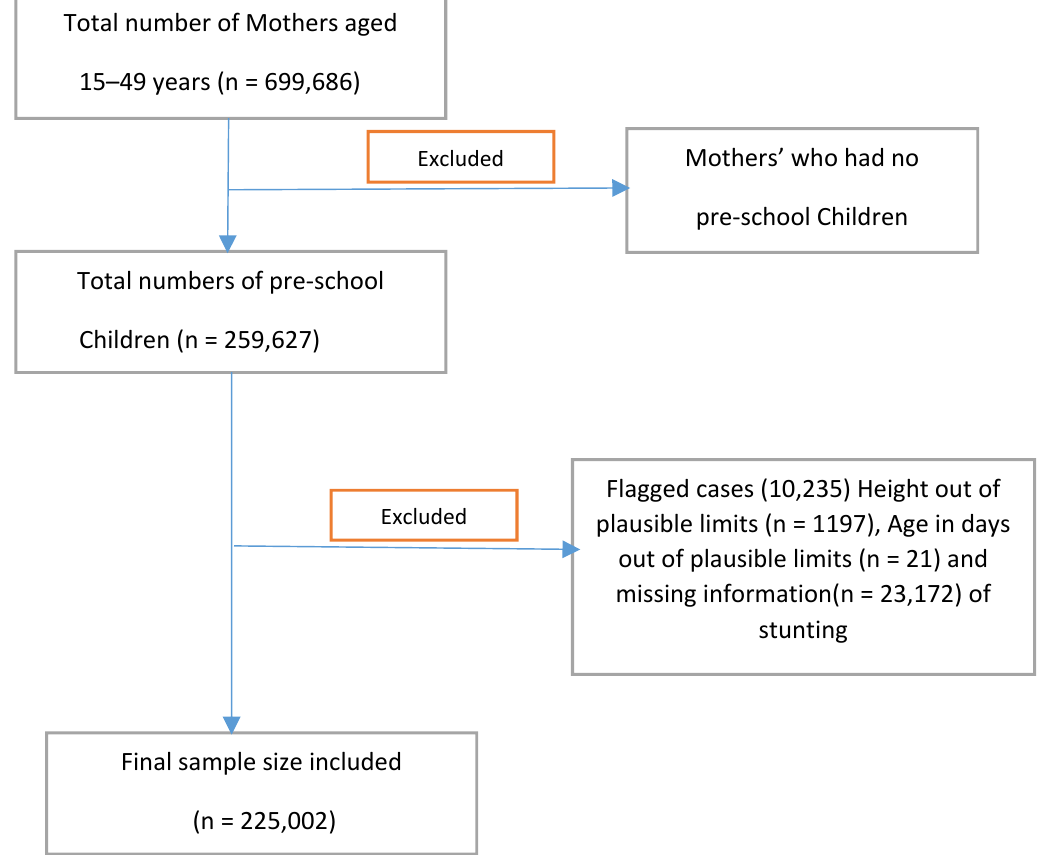
Figure 1. Flow diagram showing exclusions and final sample sizes of the study population, National Family Health Survey 2015–2016.